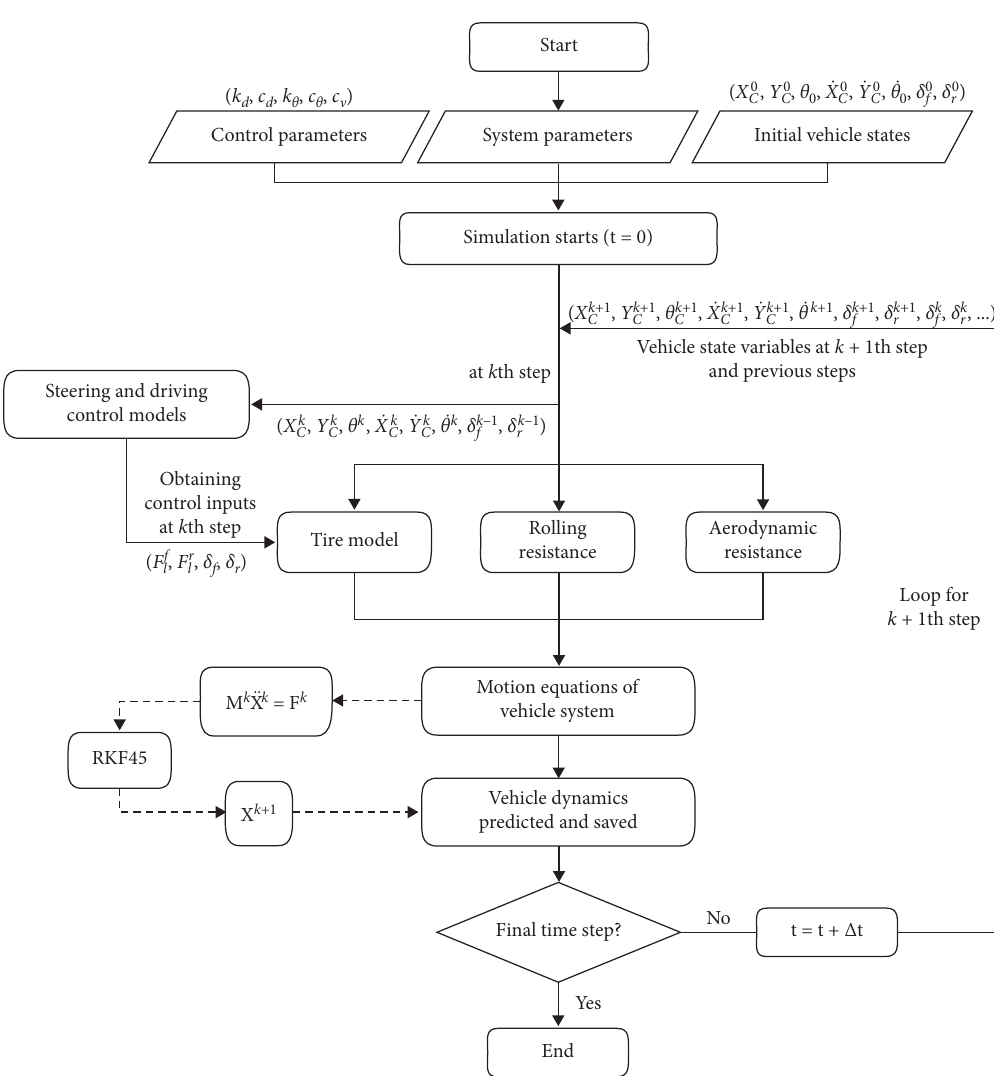
Figure 2: Computational flow diagram of the path-following simulation of the Figure 9. It can be concluded from Figure 9 that control